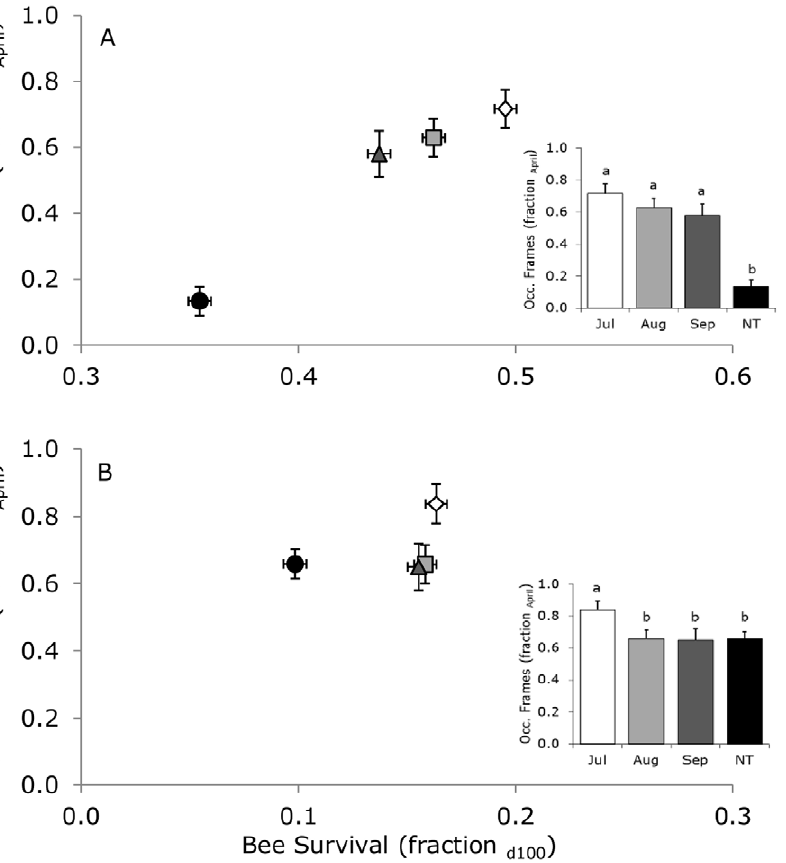
Figure 7. Winter survival as a function of bee survival in November 2005 (B) and 2006 (B). Fraction of frames occupied with bees in a colony in April in relation to bee survival at 100 days for the cohorts marked in November 2005 (A) and November 2006 (B). We used the data for November as an example, the relationship is similar for all days of marking, the trend only showed lower bee survival for cohorts marked earlier. Inserts show the differences in the fraction of frames occupied between for the different treatments (timing of acaricide application, NT=not treated). Letters indicate significant differences.